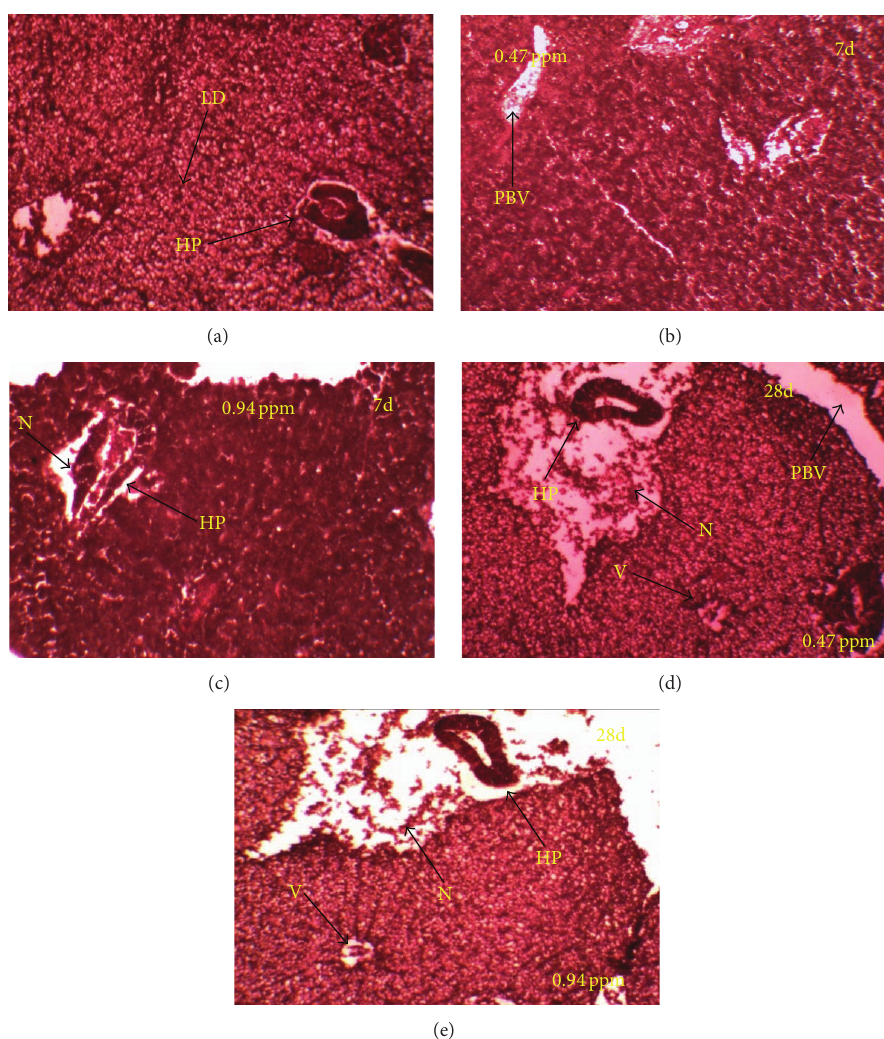
Figure 2: Histoarchitectural changes in liver (H & E stained, × 100) exposed to QP (a) control, (b) and (d) 0.47 ppm at 7 and 28 days, and (c) and (e) 0.94 ppm at 7 and 28 days. Arrows are indicating hepatopancreas (HP), lipid droplet (LD), necrosis (N), portal blood vessel (PBV), and vacuolation